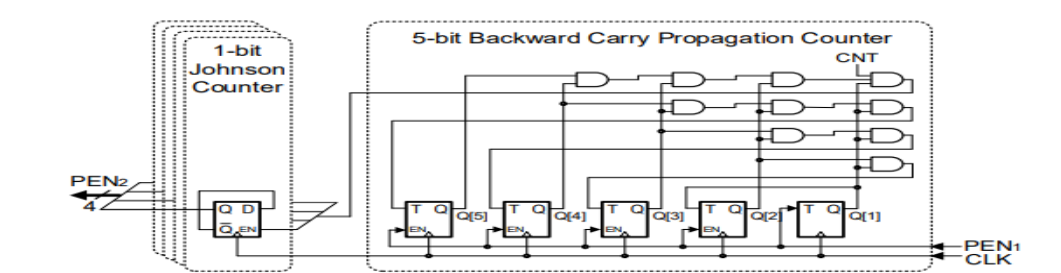
Figure 5 . Pre scaled enable signal production having redundant Johnson